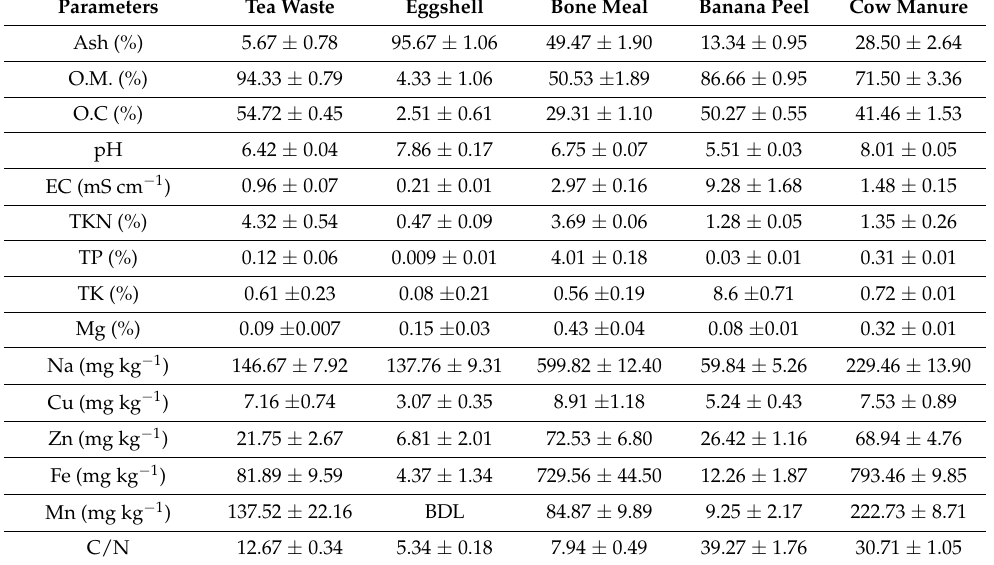
Table 1. Physicochemical characteristics of initial raw materials used in vermicomposting experi- ments. Values are mean ± SD, n =